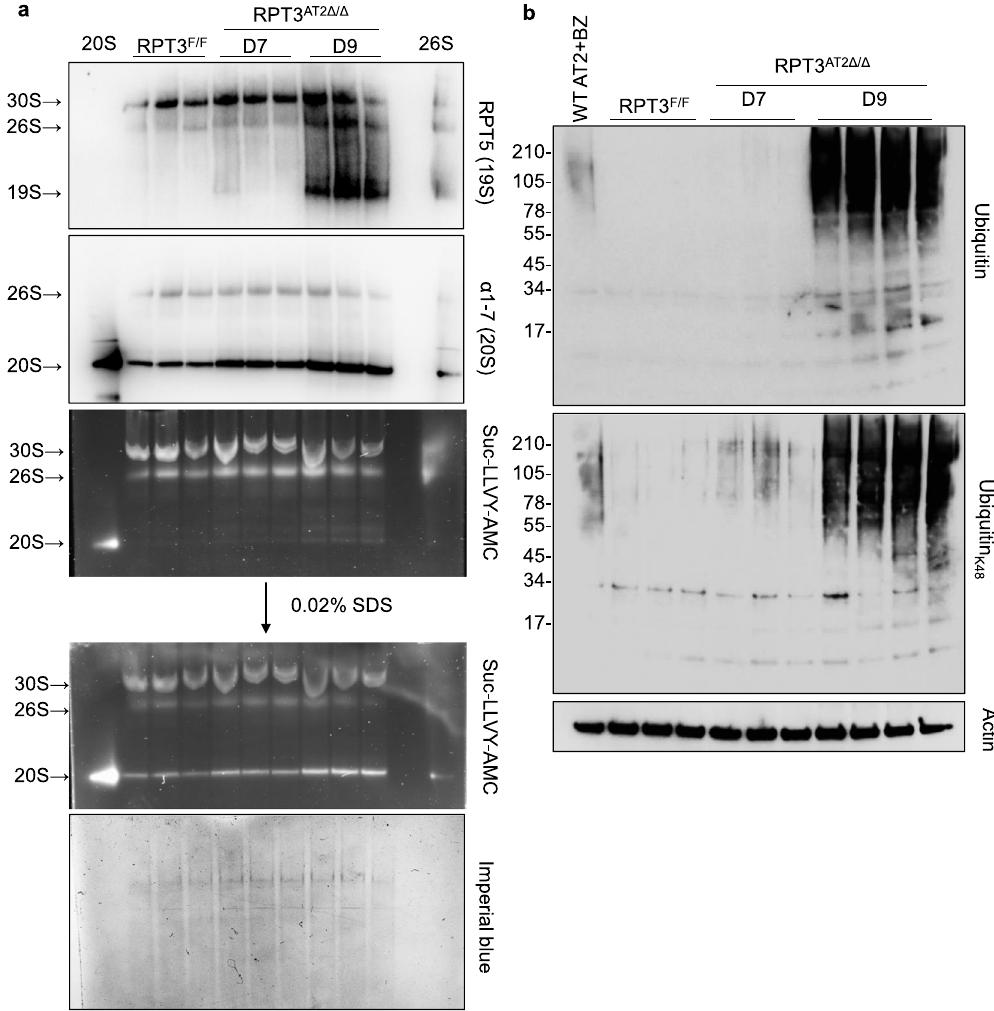
Figure 4. RPT3 deficiency is associated with increased 20S protease activity but decreased degradation of ubiquitinated substrates. ( a ) 30 μ g of AT2 cell lysates were resolved by native gel electrophoresis followed by immunoblotting for 20S α subunits (1, 2, 3, 5, 6, 7) and 19S subunit RPT5, and overlay assay with Suc-LLVY- AMC substrate. 0.5 μ g of human 26S proteasome and bovine 20S proteasome were used as controls. Addition of SDS stimulates 20S peptidase activity. Gel was stained post transfer with imperial blue to assess protein transfer. ( b ) 20 μ g of AT2 cell lysates were separated by SDS-PAGE followed by immunoblotting for polyubiquitin and K-48 linked polyubiquitin. WT AT2 cells cultured on 100% Cultrex were treated with 10 nM Bortezomib (BZ) for 48 hours. Cultrex was dissolved using Cell Recovery Solution and cells were collected in 2X sample buffer containing BME for Western blotting. RPT3 F/F - Sftpc WT/CreER :RPT3 F/F mice without tamoxifen treatment. Full- length blot for Actin is presented in Supplementary Fig.